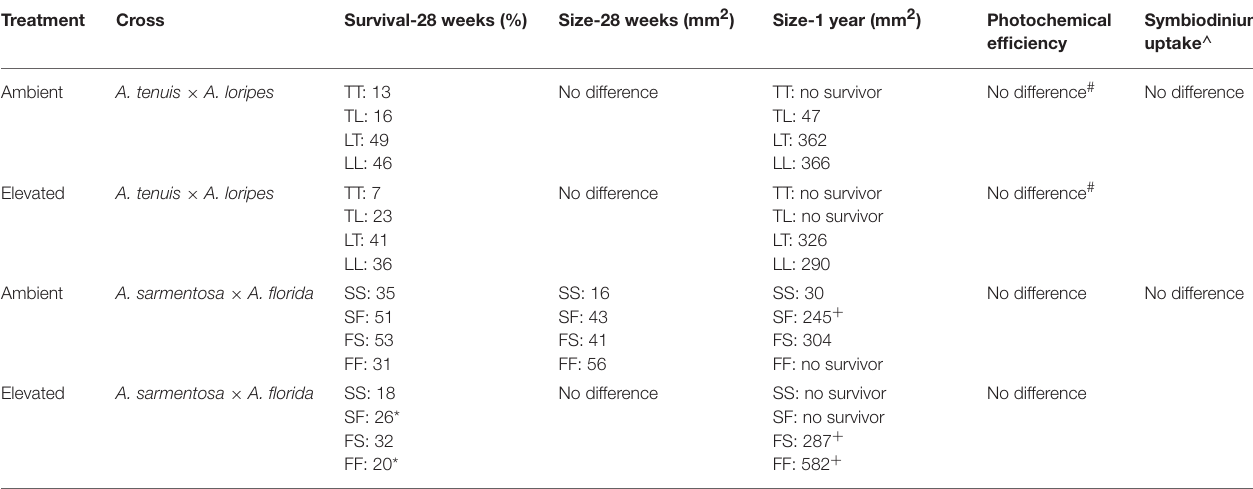
Symbiodinium efficiency uptake ∧